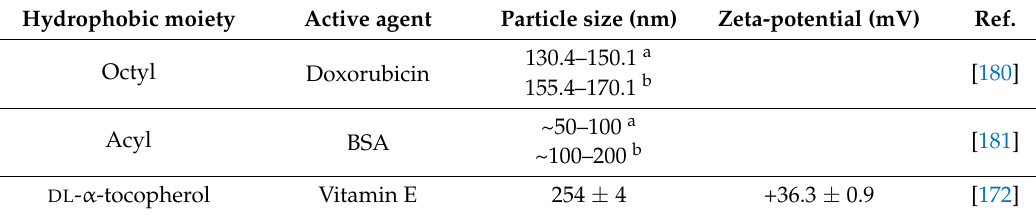
Table 7. Hydrophobically modified succinyl chitosan.